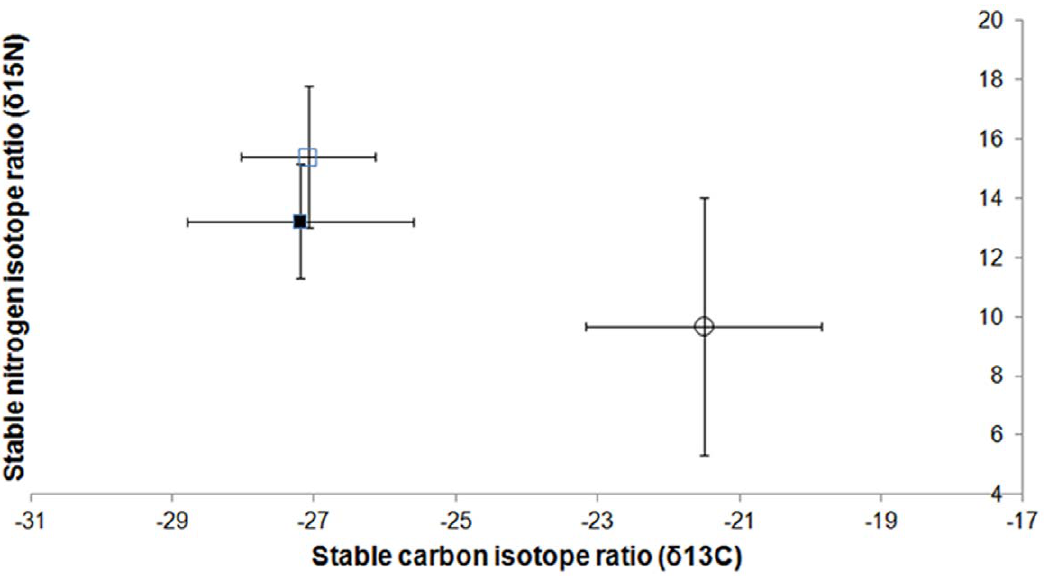
Figure 1. Stable carbon and nitrogen isotope ratios for samples collected in Cuatro Cie´negas, Mexico. Samples: water lilies (open circle), substrate (filled square), and snails (open square). Ratios are shown with 6 one standard deviation. N=9 sites for water lilies, N=10 sites for substrate and snails.